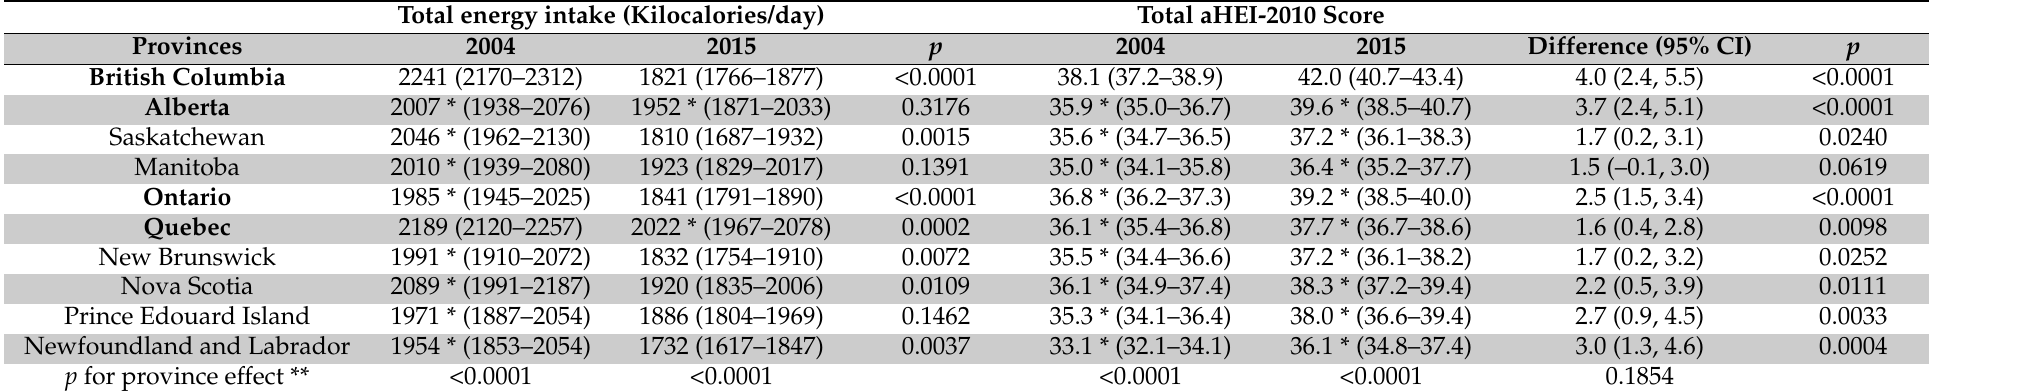
Table 4. Adjusted a mean energy intake and alternate Healthy Eating Index 2010 (aHEI-2010) total score and 95% confidence intervals by province of residence of adults from the Canadian Community Health Survey (CCHS)-Nutrition in 2004 and